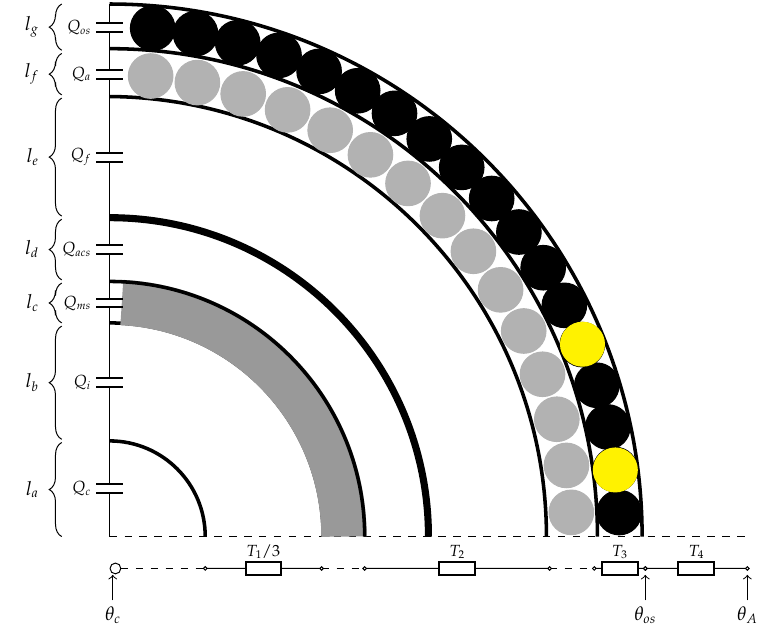
Figure 9. Quarter cross-sectional area of a single-core XLPE SL-type equivalent submarine cable with thermal resistances T and thermal capacitances Q represented along the